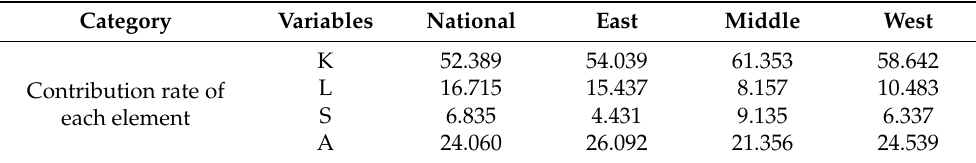
Table 4. Comparison of element contribution